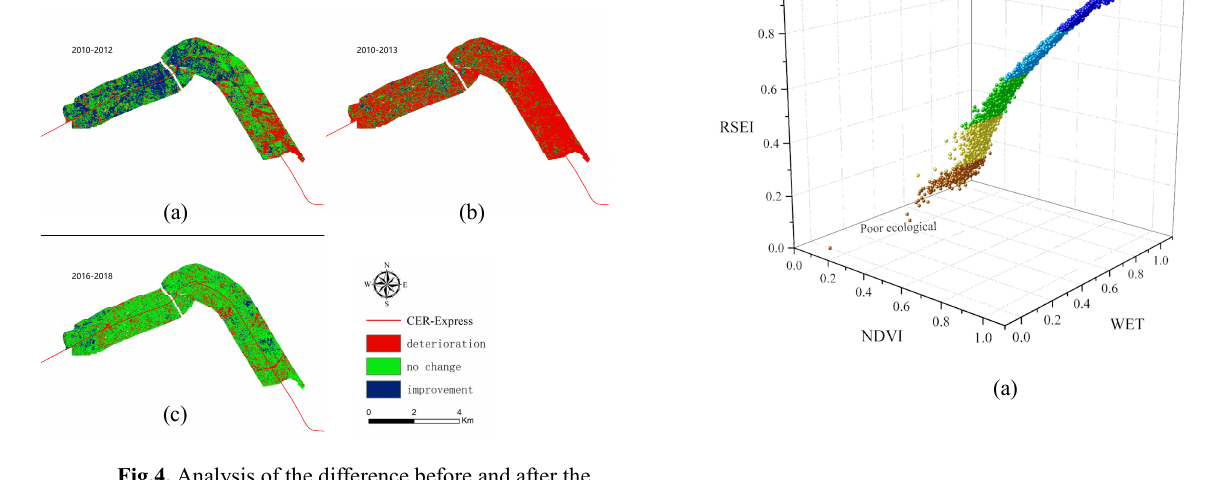
Fig.4. Analysis of the difference before and after the opening of the CER-Express. ( a ) RSEI difference between